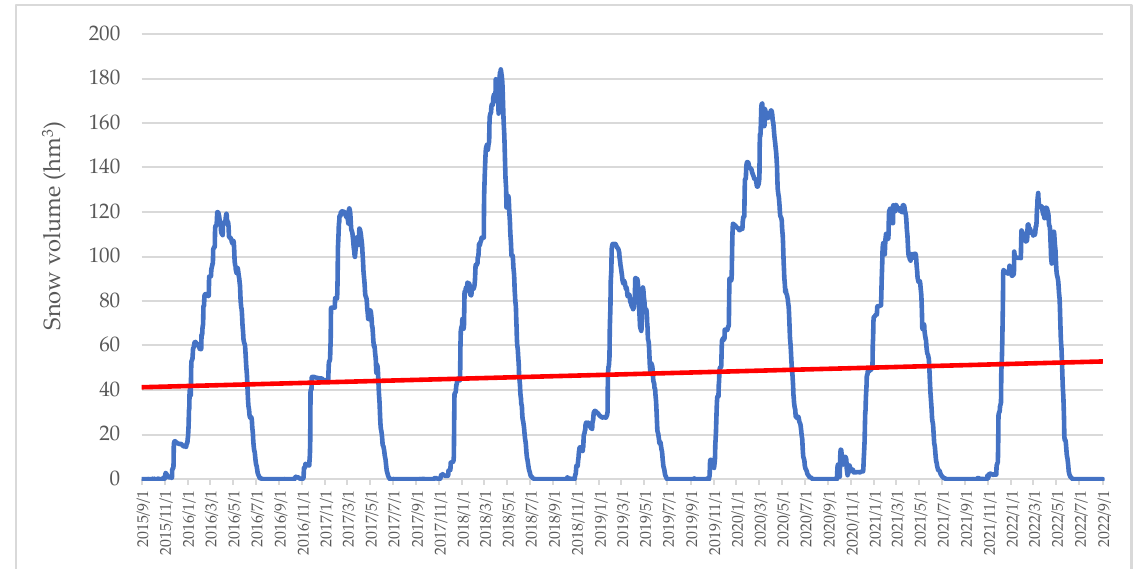
Figure 10. Evolution of daily snow, as equivalent water volume (hm 3 ), in the upper Gállego River basin (up to the Búbal Reservoir), from September 2015 until September 2022. Trend line (red). Data source and methodology: CHE-SAIH [49,51,52].